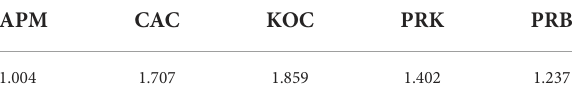
TABLE 2 Full collinearity